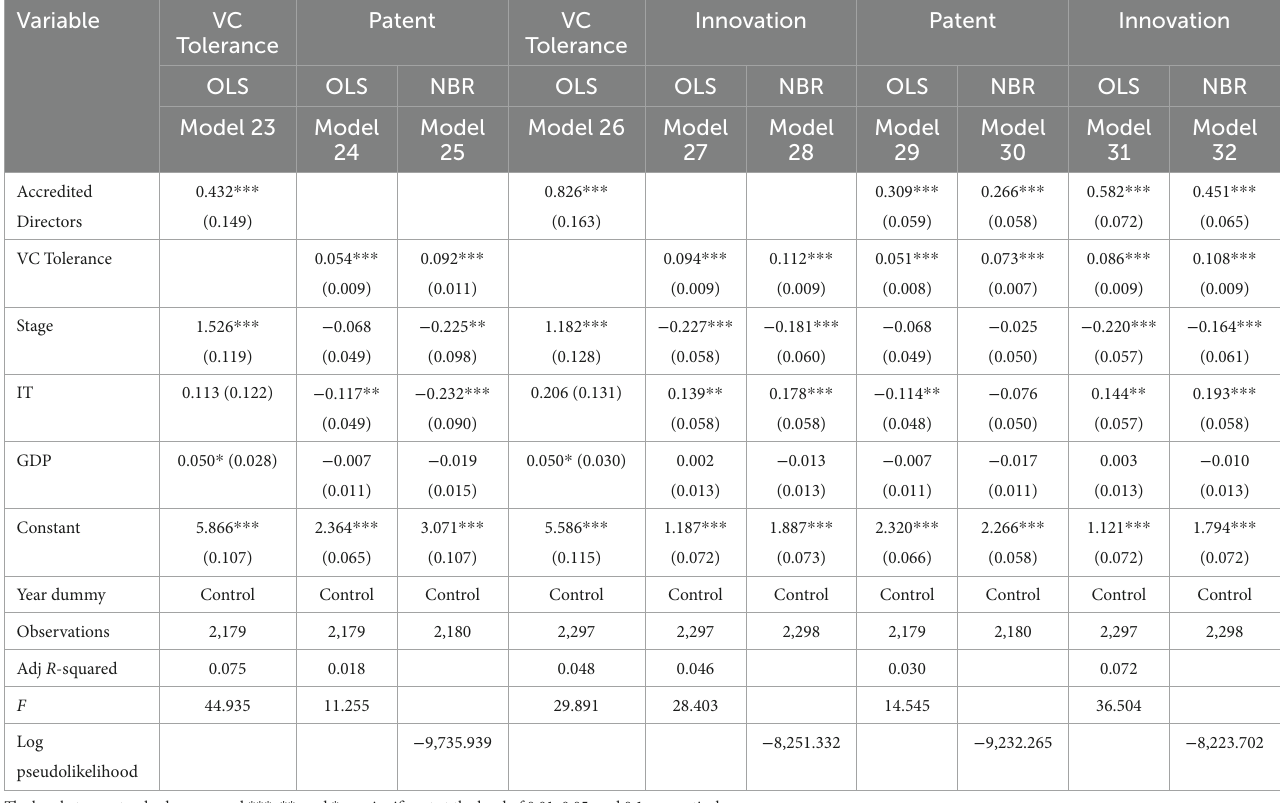
TABLE 6 Impact of dispatched directors and failure tolerance of venture capital on enterprise innovation performance. Variable